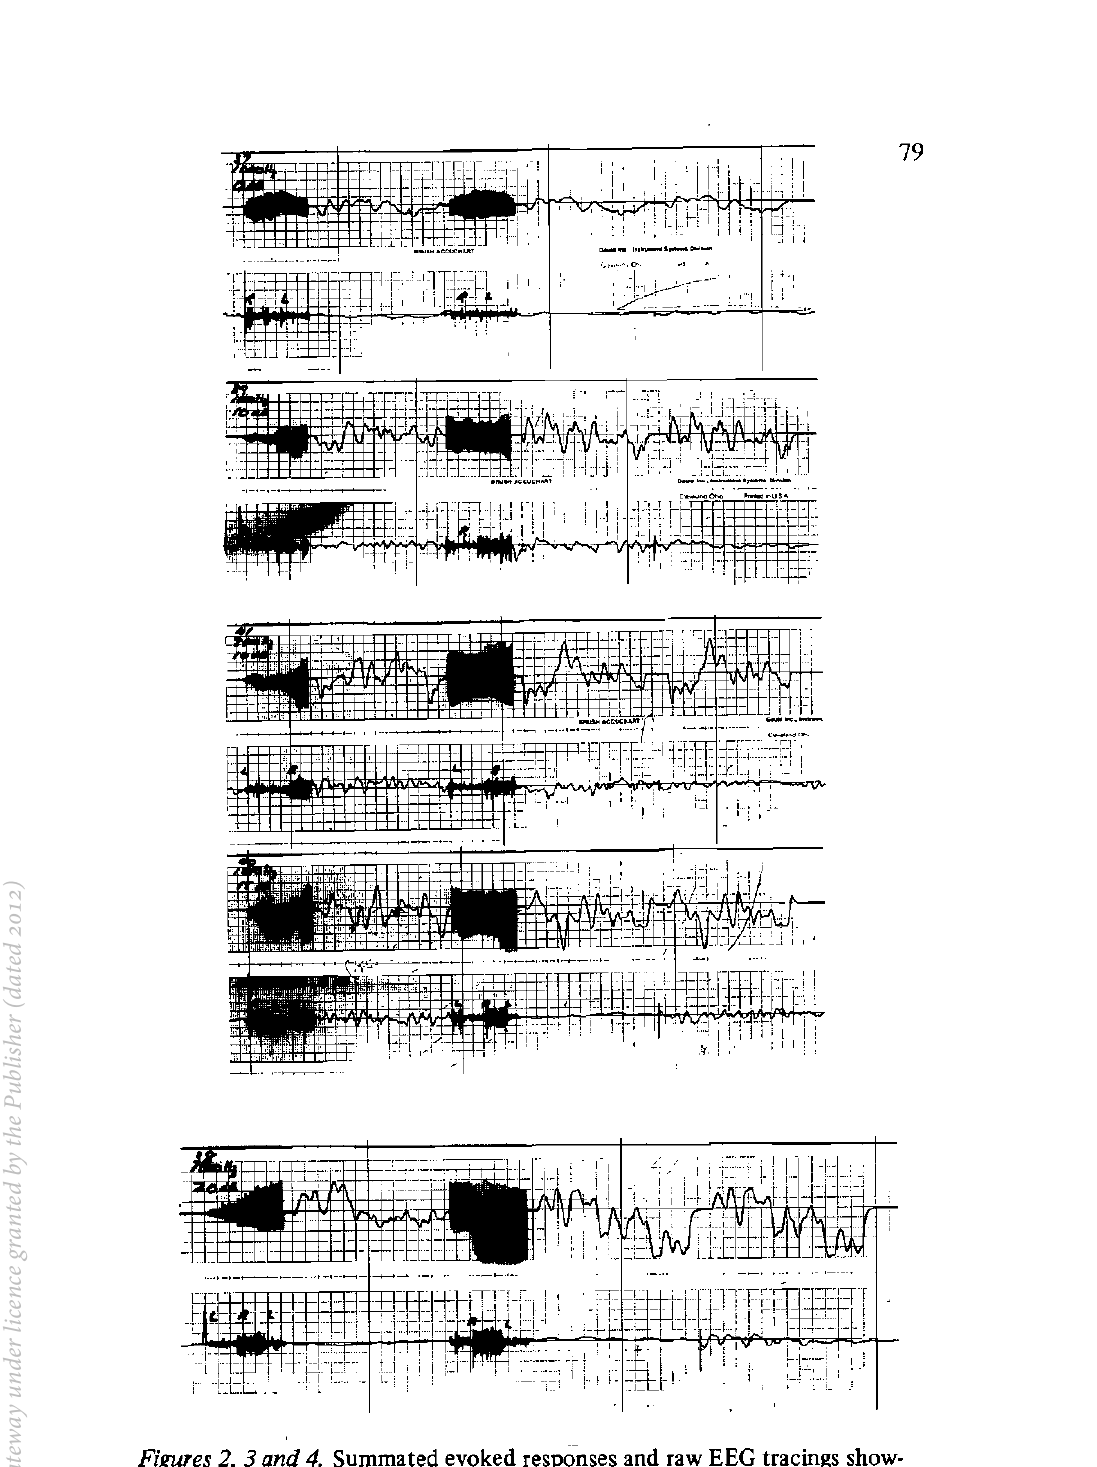
Figures 2, 3 and 4. Summated evoked responses and raw EEG tracings show- ing the effect that switching from left to right ear has on the EEG tracings. Sensitivity